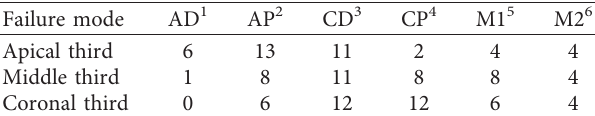
1 Adhesive failure between dentin and cement (no cement remaining on the post). 2 Adhesive failure between cement and post (post is entirely covered with resin cement). 3 Cohesive failure in dentin. 4 Cohesive failure in the post. 5 Mixed failuresuchthat0%to50%ofthepostsurfacewascoveredwithcement. 6 Mixed failure such that 50% to 100% of the post surface was covered with